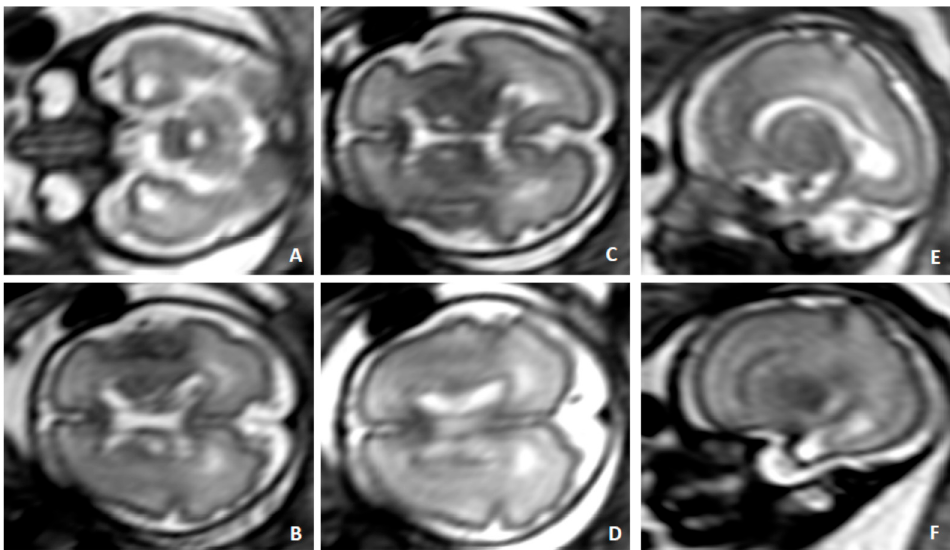
Figure 3. Fetal MRI, 30 GW of Case 2; SSHTSE (Single Shot Turbo Spin Echo) sequences and transverse ( A – D ) and sagittal images ( E , F ). Typical temporal pole abnormalities: temporal horn enlargement with cystic appearance ( A – F ), ventricular septation and white matter hyperintensity. Diffuse white matter hyperintensity. Multiple subependymal cysts.